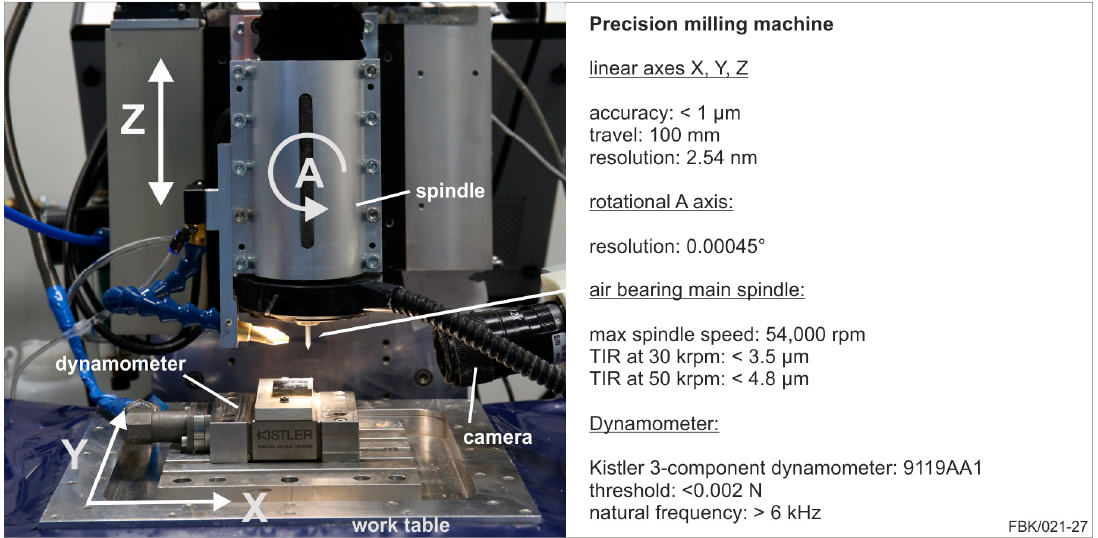
Figure 2. Precision 4-axes machine after [19].